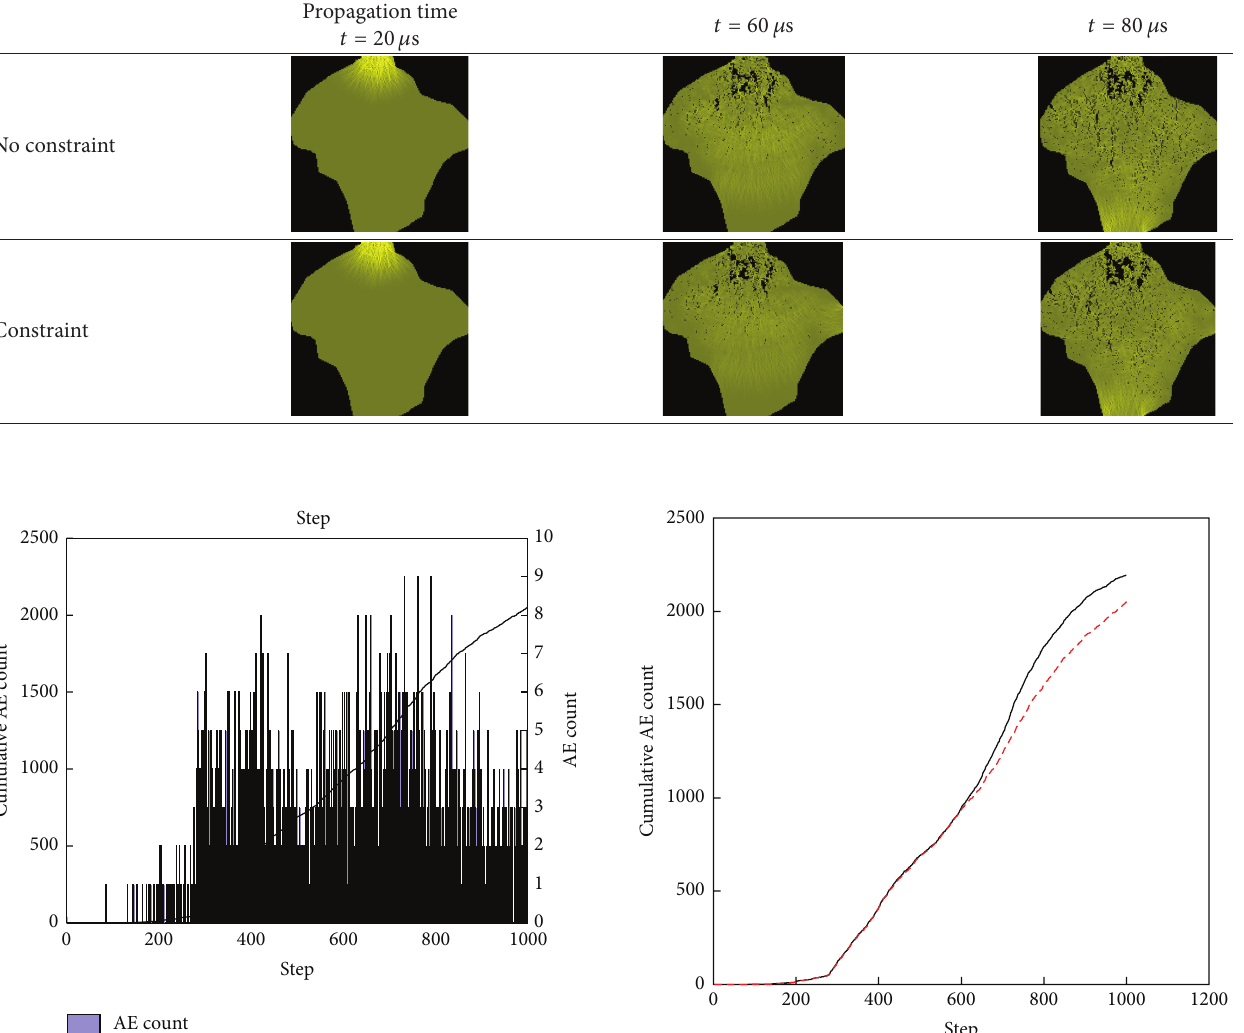
Table 4: The failure process of sample with no constraint and constraint.